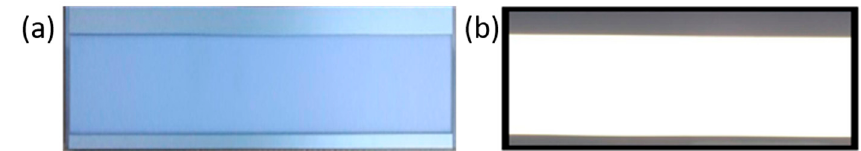
Figure 16. Illumination conditions of proposed light source module: ( a ) shut down and ( b ) in operation.